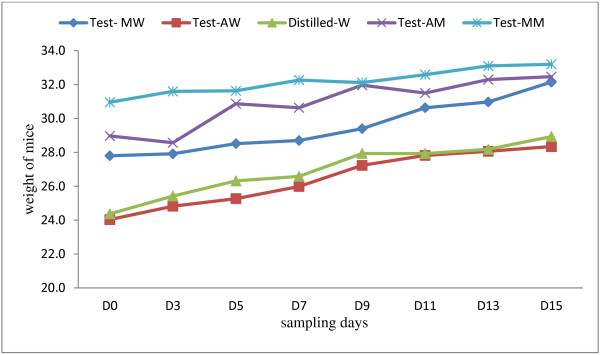
Weights of uninfected mice during subacute toxicity testing. The mice were given either water and methanol extracts of A. absinthium and M. stenopetala or water only (MW = M. stenopetala in water, AW = A. absinthium in water, Distilled-W = water, AM- A. absinthium in methanol, MM- M. stenopetala in methanol).